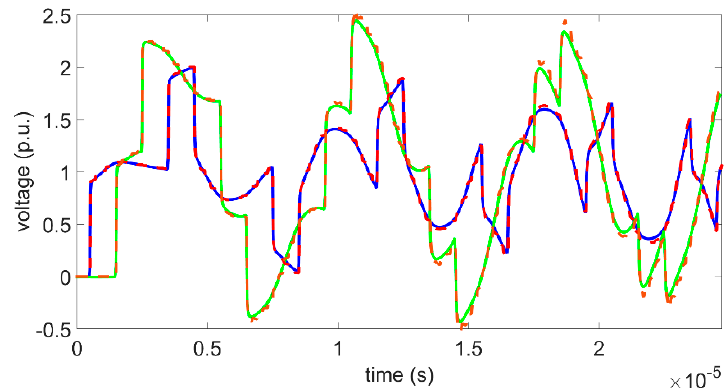
Figure 8. Comparison of transient voltage waveforms at two specific distances between the computed results with the proposed method (solid lines) and results obtained with ATP simulations (dashed lines). The solid blue and dashed red lines correspond to voltage measurements at 150 m from the sending node; the solid green and the dashed orange lines were obtained at 450 m. The oscillations observed in the results from the ATP simulations are attributed to the error accumulation due to the discretization of the transmission line [2].